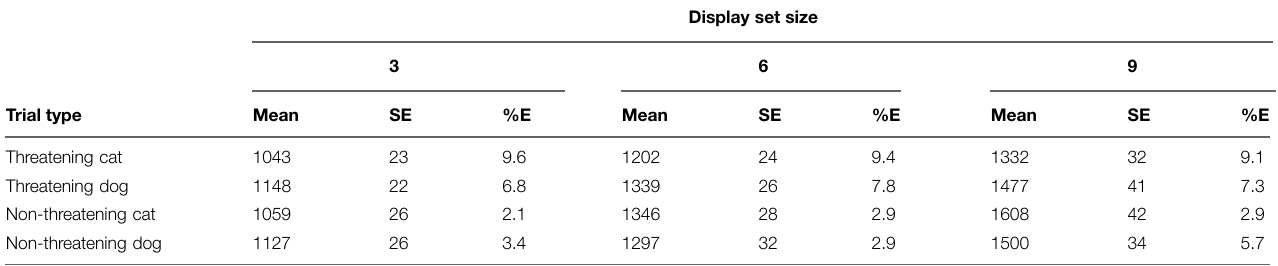
TABLE 2 | Mean RTs, SE, and mean percentage error rates (%E) for the various conditions of interest in the classification task in Experiment 1.